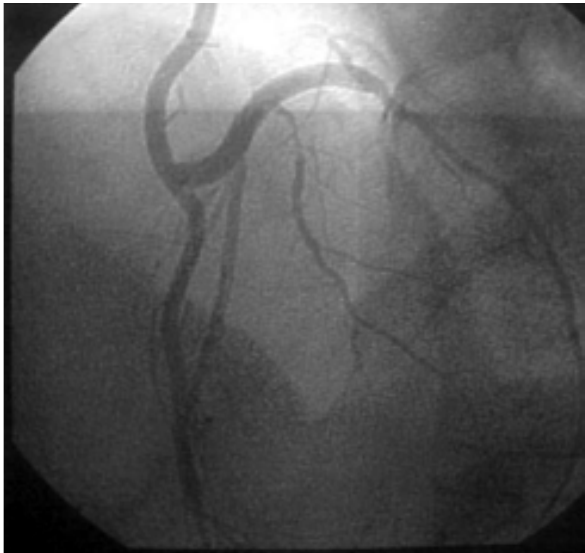
Fig. 2 - Estudo angiográfico de um enxerto composto de ATIE revascularizando a AIA e um segmento de VSM oriundo da ATIE revascularizando uma artéria marginal da circunflexa. Incidência oblíqua anterior esquerda crânio